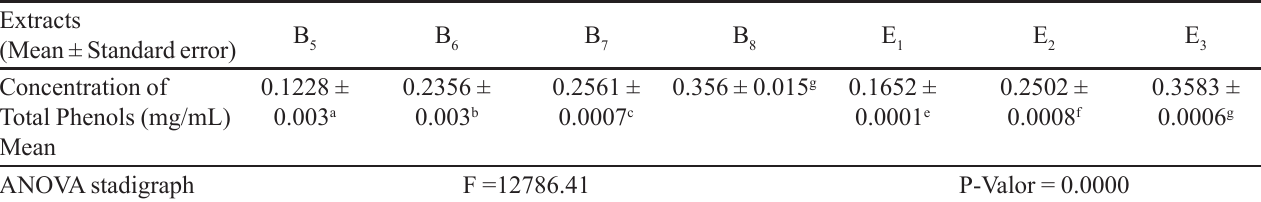
TABLE IV - Values of the concentration of total phenols expressed as tannic acid for each one of the extracts